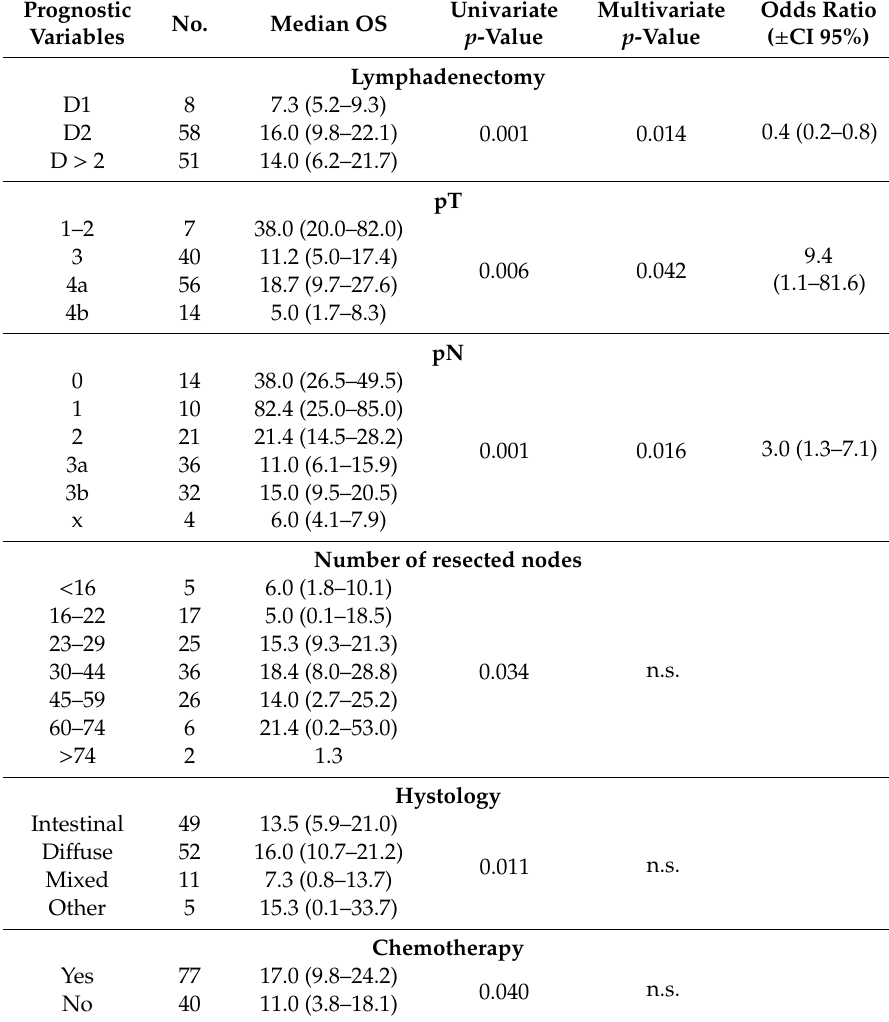
Table 5. Prognostic factors: univariate and multivariate analyses (R0